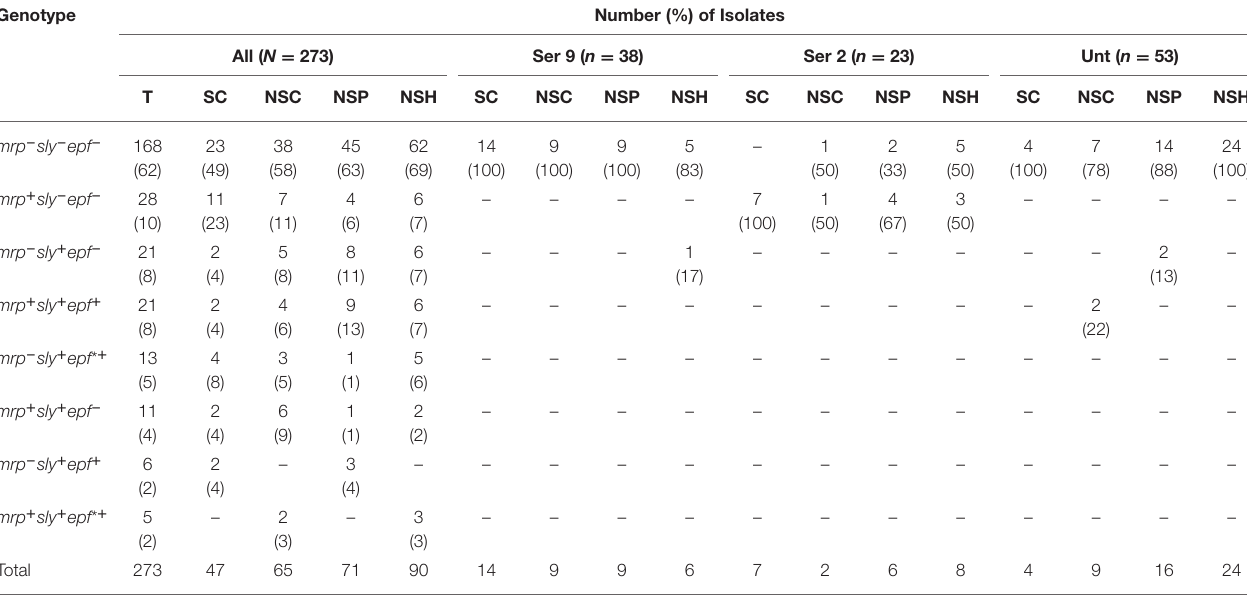
TABLE 3 | S. suis genotypes based on classical virulence markers (40, 42–44).